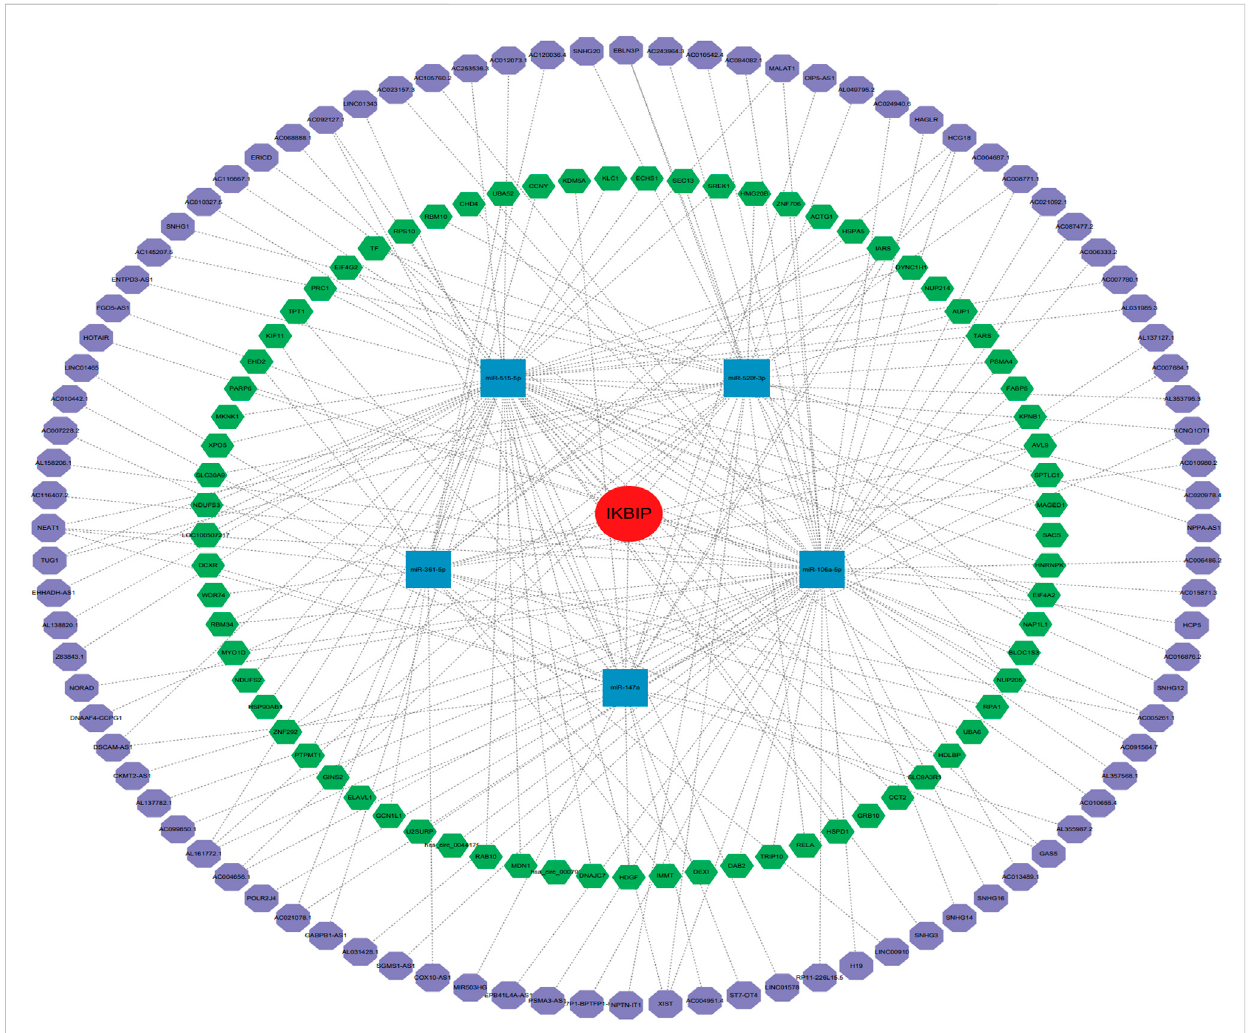
FIGURE 9 IKBIP ’ s ceRNA network. IKBIP ceRNA networks (red circle represents the hub gene, blue squares represent the miRNAs, green hexagons represent lncRNAs, and purple hexagons represent